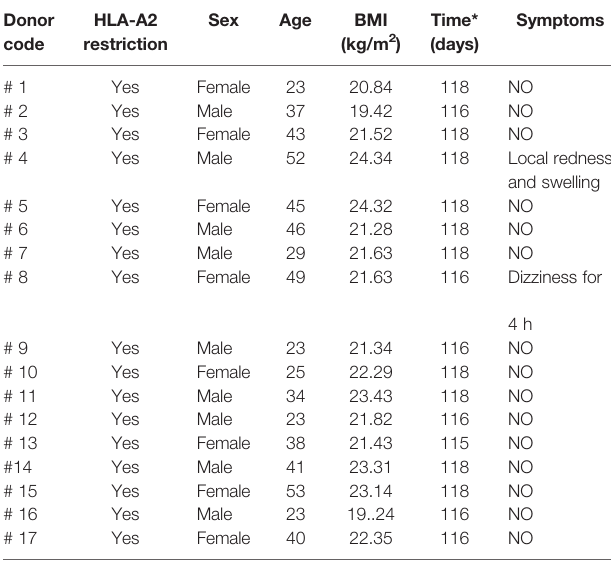
*The time interval between the second injection vaccination and blood sampling.